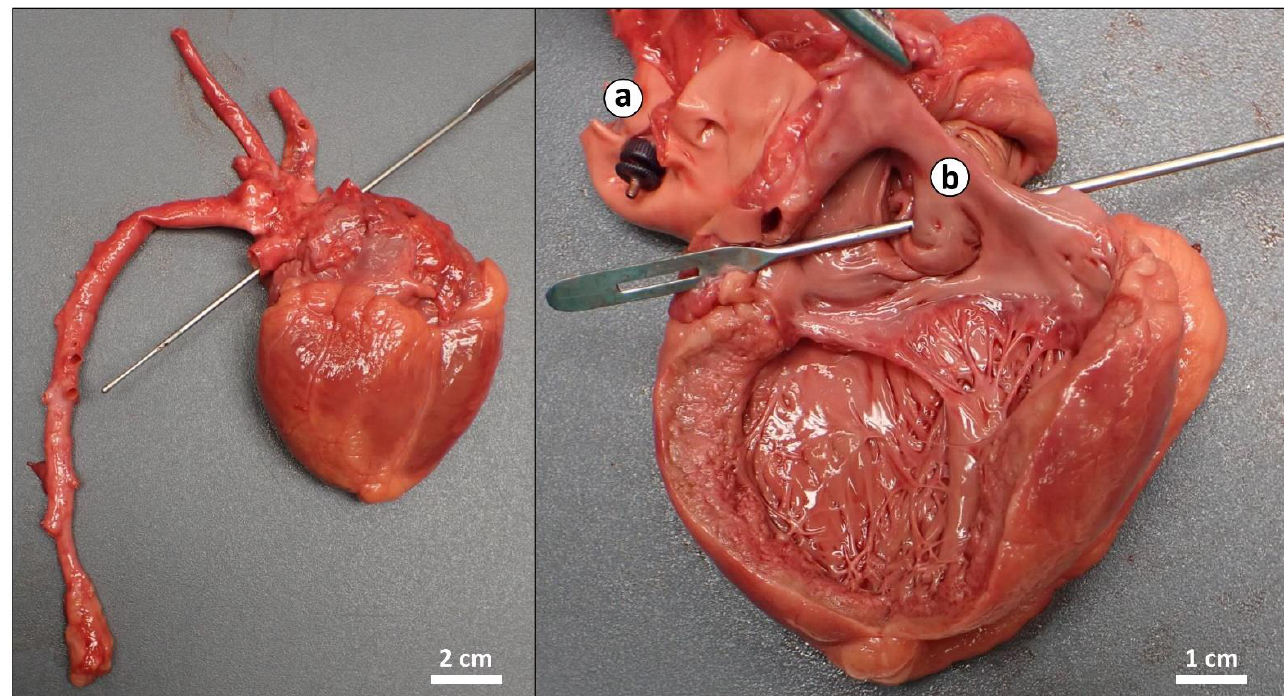
Figure 3. Gross images of the heart. A ductus arteriosus with black metallic plug device in place (status post closure of patent ductus arteriosus) is noted ( a ). An atrial septal defect was also noted ( b ).